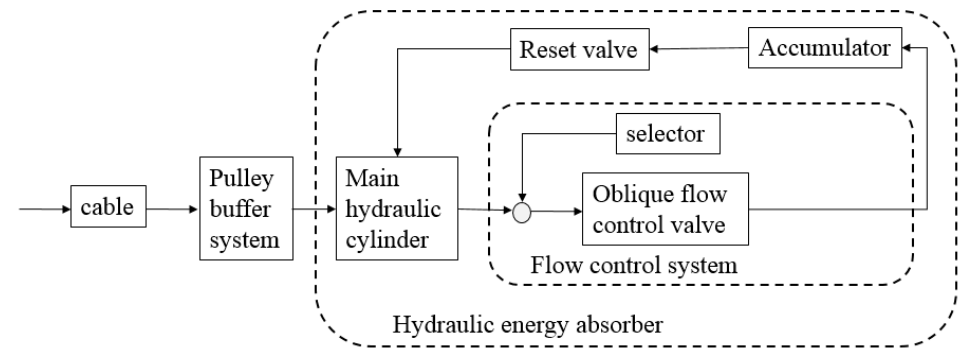
Figure 4. Principle diagram of the arresting gear energy absorber.